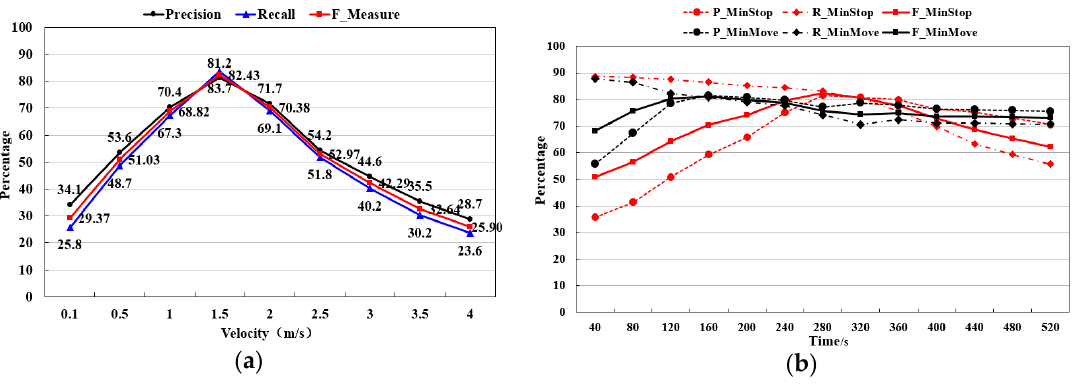
Figure 8. The precision and recall of different parameter thresholds. ( a ) Analysis of the MaxAv parameter; ( b ) Analysis of the MinStop and MinMove parameters.